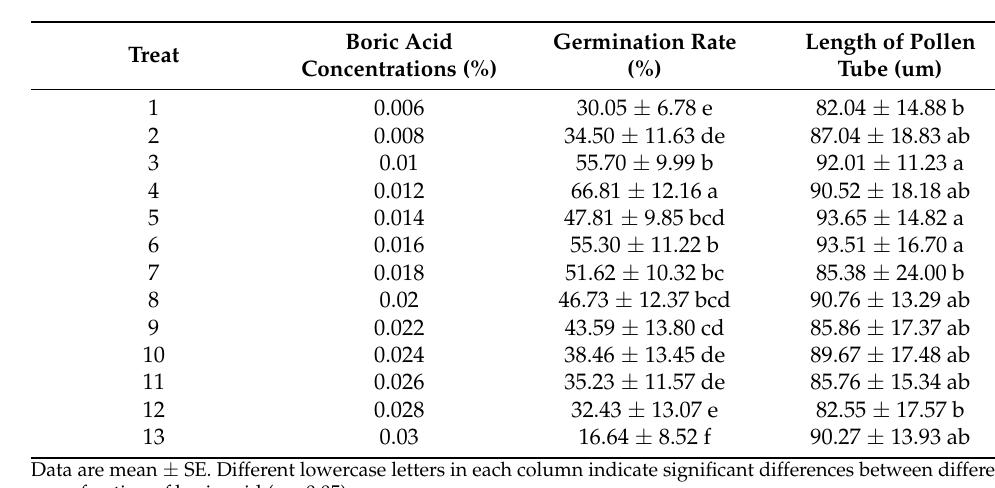
Table 4. The effect of different mass fraction of boric acid on pollen germination of T. distichum var. distichum .